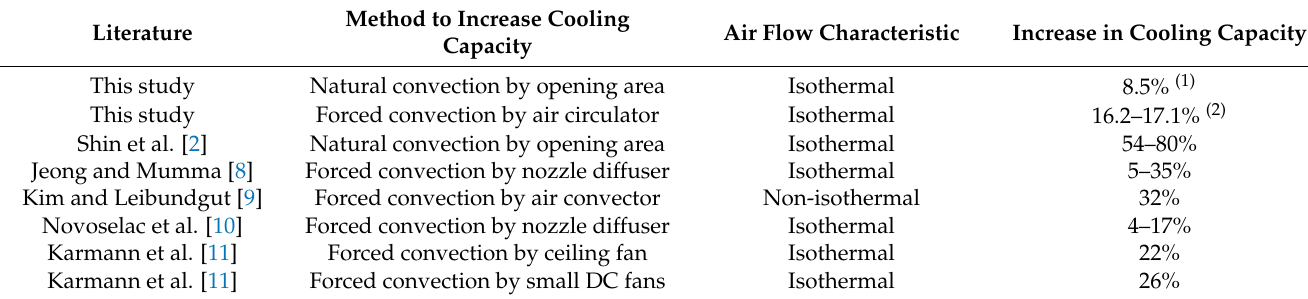
Table 6. Comparison with previous studies on cooling capacity enhancement.